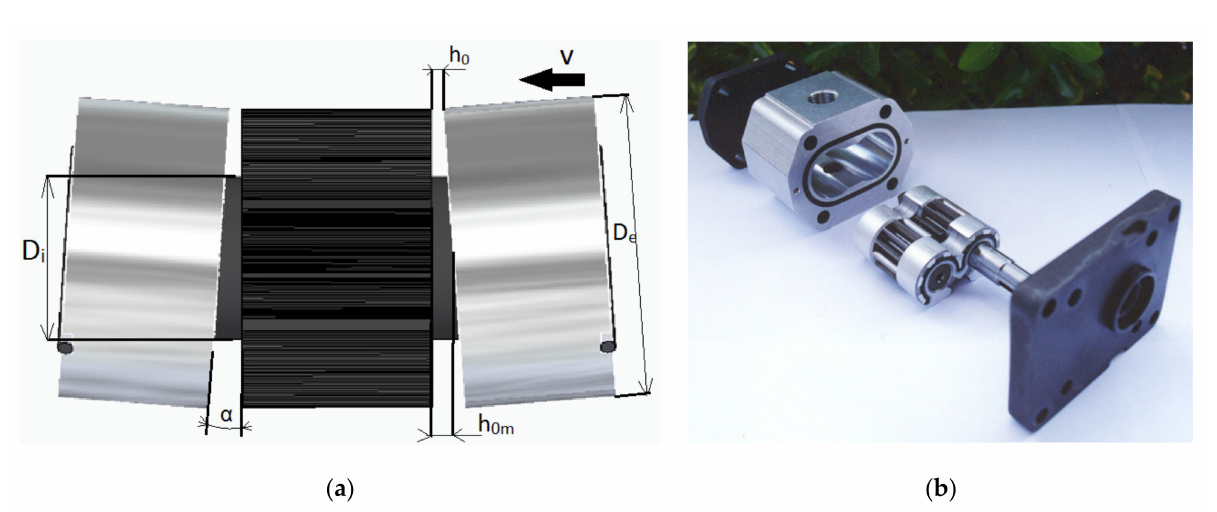
Figure 7. ( a ) Significant dimensions; ( b ) gear pump